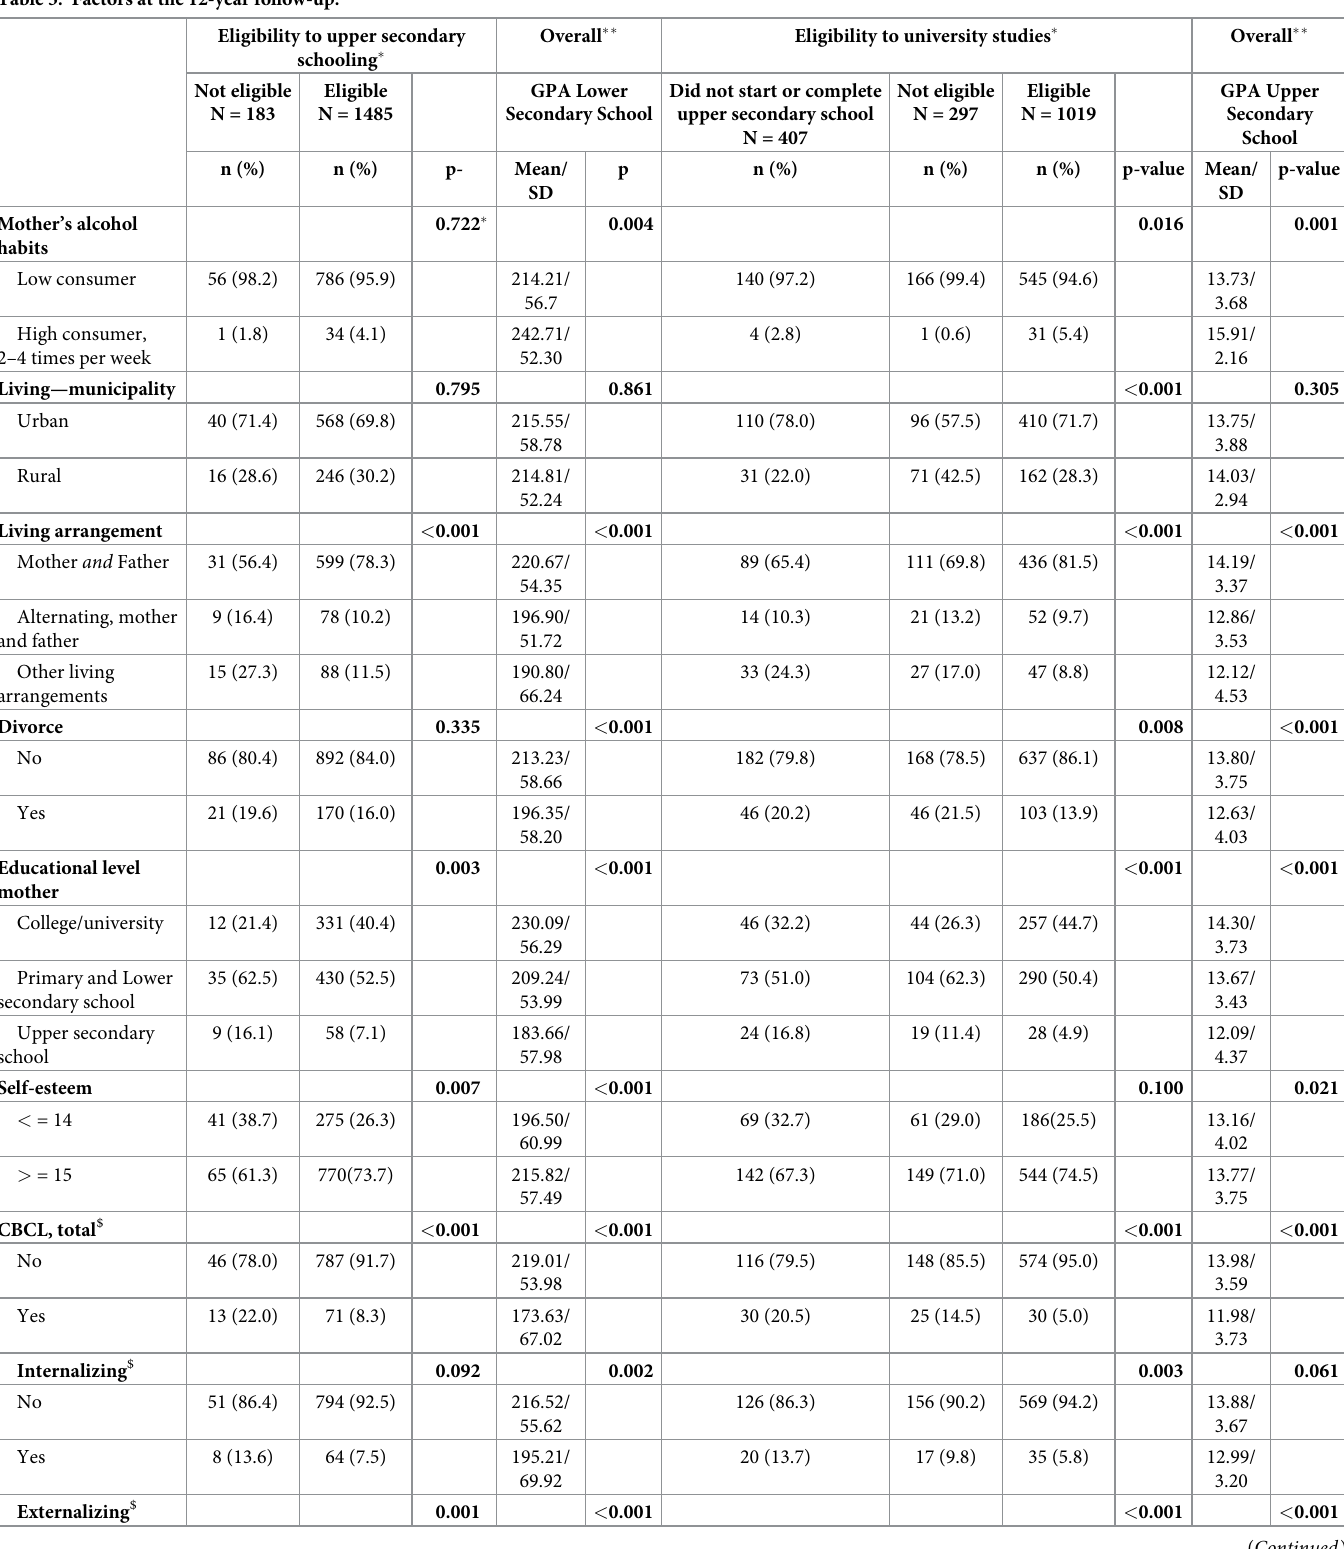
Table 3. Factors at the 12-year